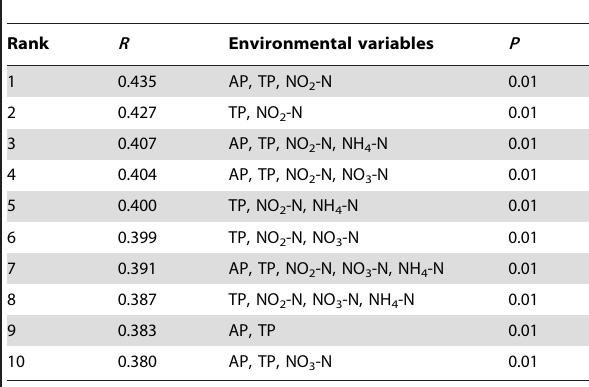
Table 2. Result of biota-environment (BIOENV)